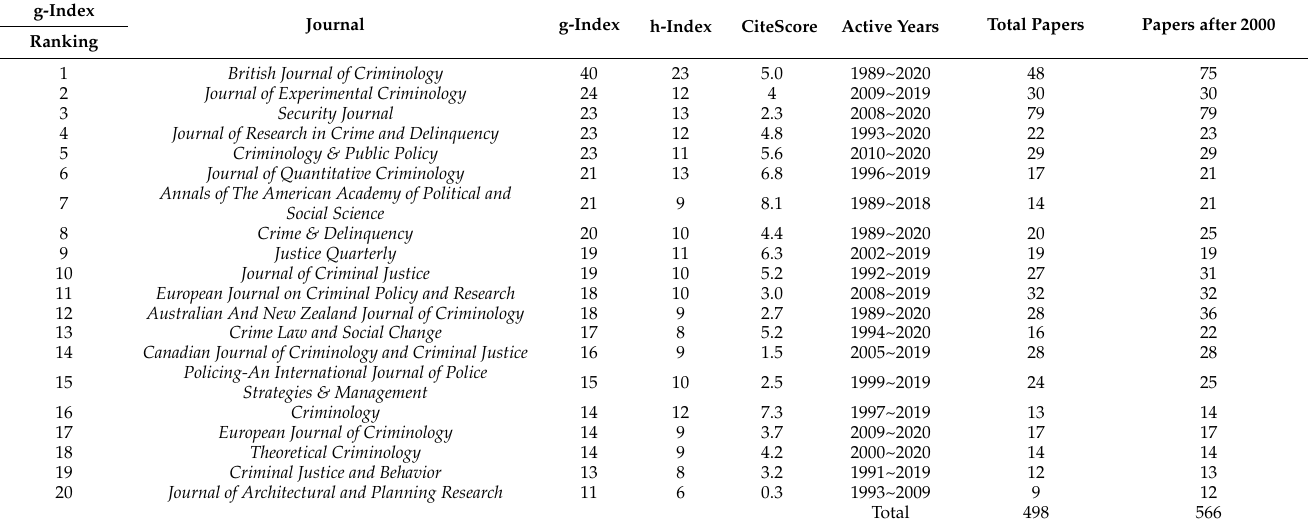
Table 1. The top 20 most influential journals.